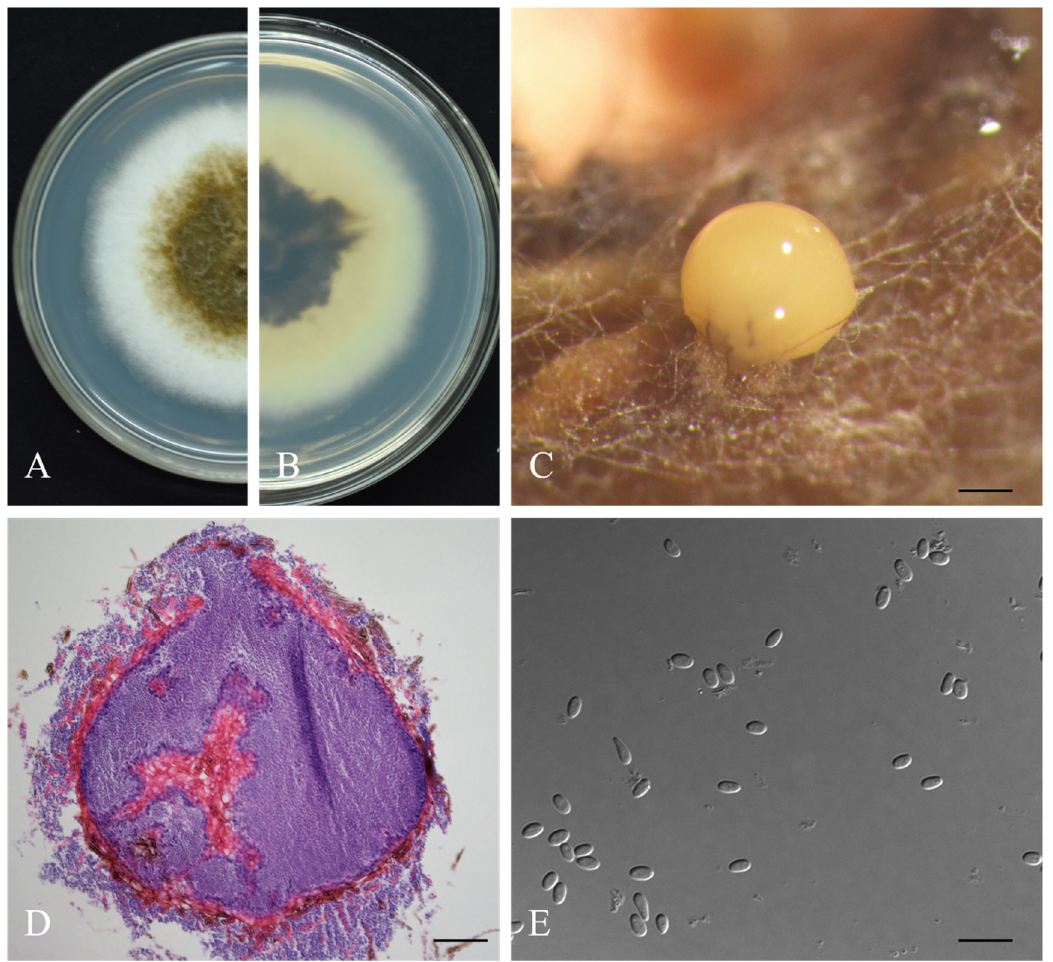
Figure 4. The morphologies of Didymella theae . ( A , B ) Front and back views of colonies cultured on PDA for 7 days, respectively. ( C ) Conidioma. ( D ) Section view of pycnidia. ( E ) Conidia. Scale bars indicate 200, 50, and 10 µ m in panels ( C ), ( D ) and ( E ) respectively. Culture characteristics. Colonies on PDA medium, 67.5 mm diam after 7 d. Colony surface brown, margin regular, densely covered by white fluff, white aerial mycelia, reverse dark brown. Spherical light-yellow conidiomata formed on the mycelial surface as cultured over 14